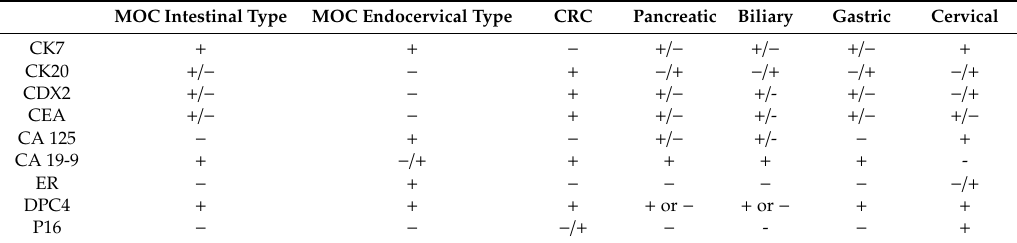
Table 1. Summary of the IHC expression of MOC and metastatic mucinous